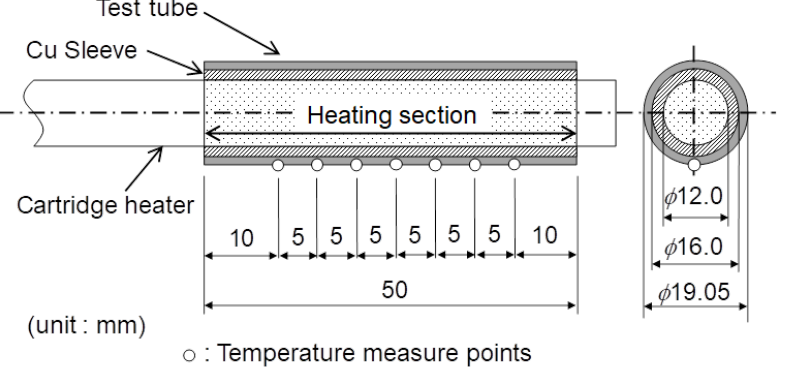
Figure 2. Details of the test section.